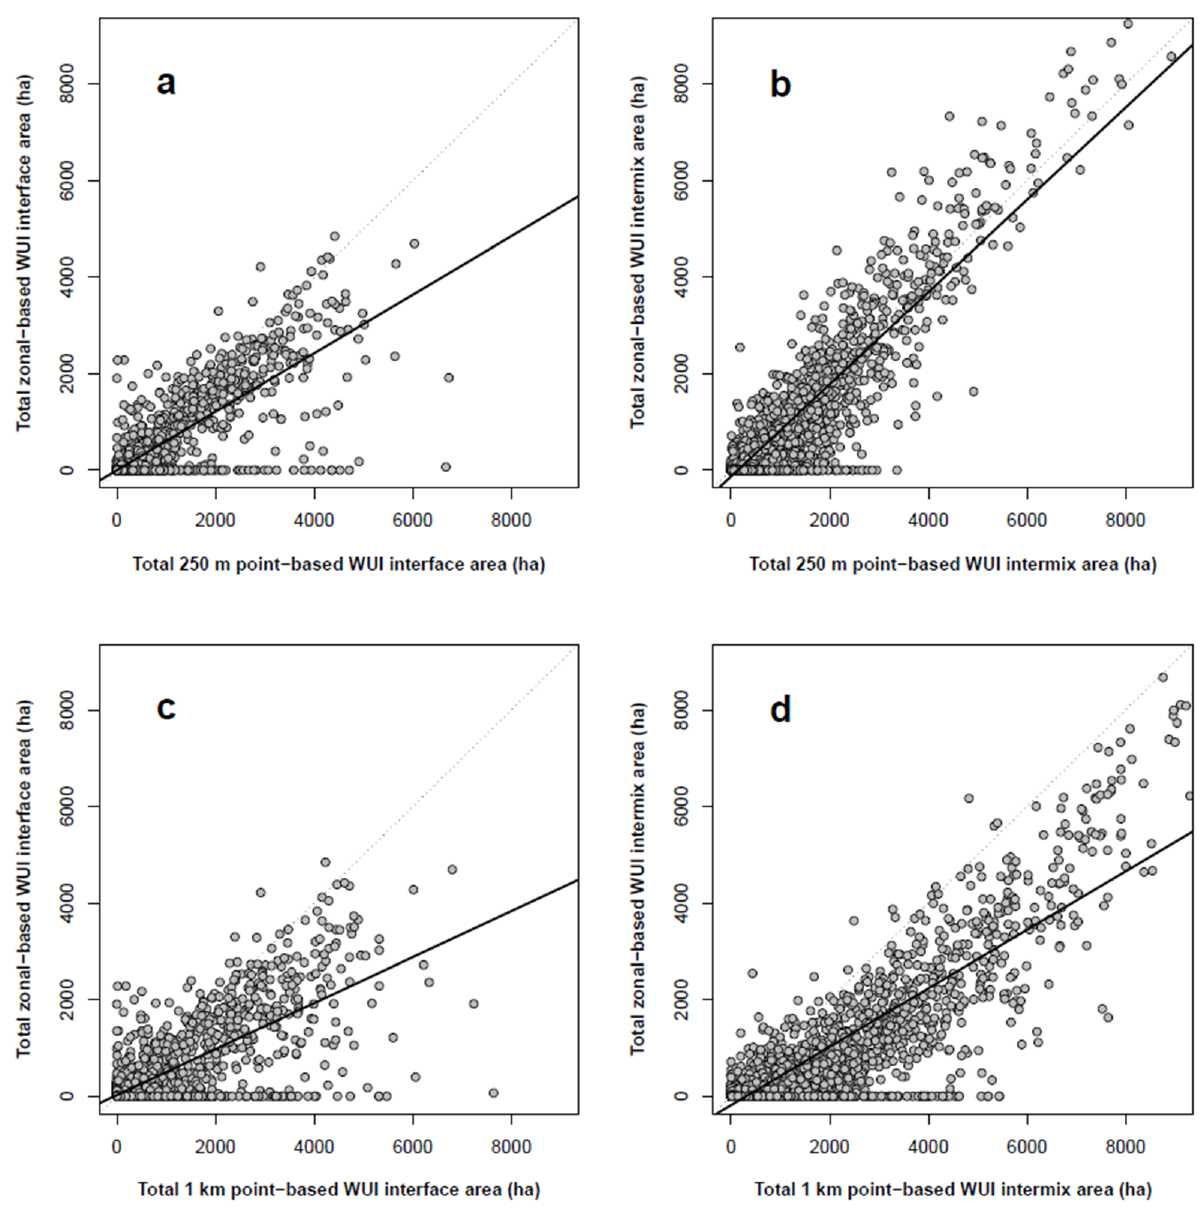
Figure 5. Relationships between the total area of interface (panels a , c ) and intermix WUI (panels b , d ) as quantified by the zonal-based (Y axes) and the point-based (X axes) WUI mapping approaches. In the top row, point-based WUI is based on a 250 m buffer, whereas in the bottom row, it is based on a 1 km buffer. In all panels, the dotted lines depict a 1:1 relationship between axes, whereas the solid lines depict the slope of a simple linear model fit to the data.